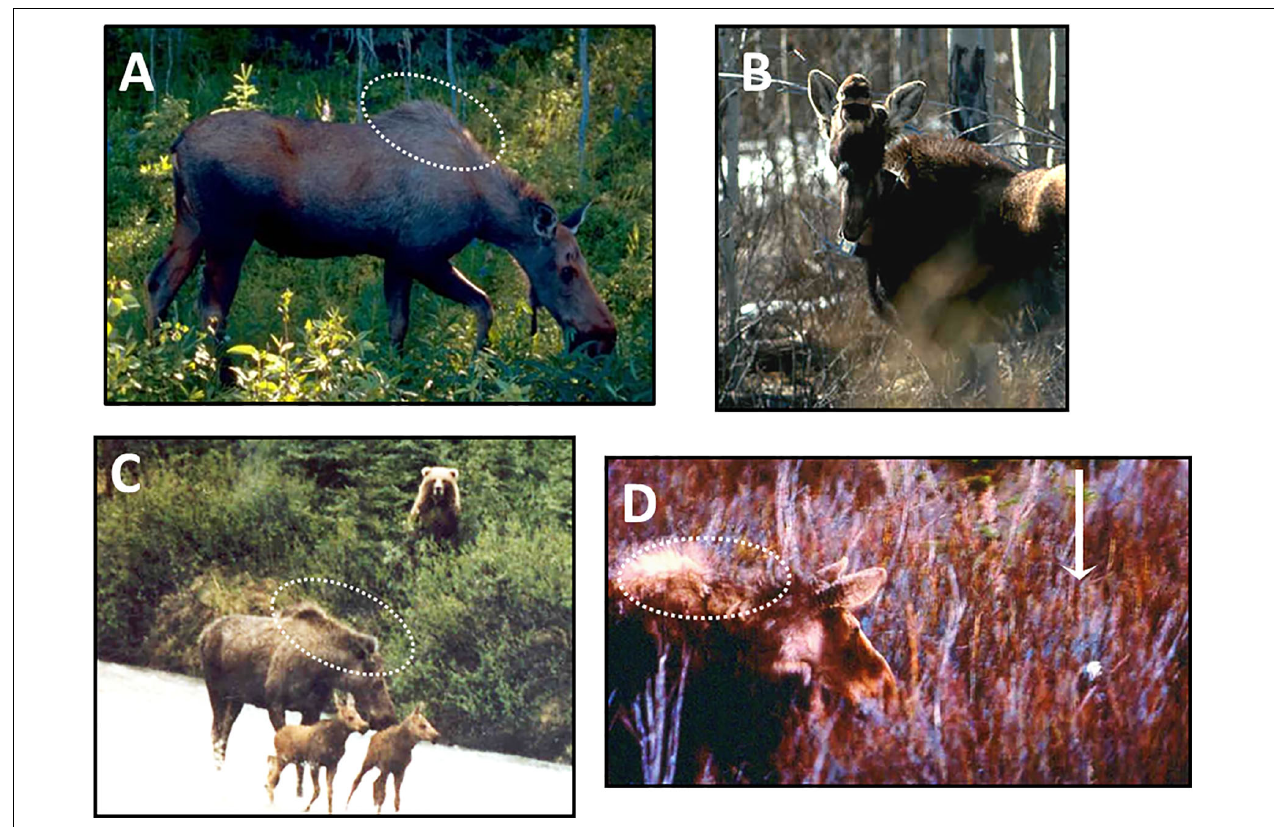
FIGURE 2 | Typical response of moose when exposed to a familiar predator and its cues. (A) Moose with little obvious concerns of eternal threat. (B) Olfactory response to exposure of wolf urine delivered by a projectile. (C) Pilo-erection and retraction of ears during interaction with a grizzly bear. (D) Pilo-erection but no ear retraction in a naïve moose with no prior exposure to grizzly bear feces (wrapped in porous tissue).